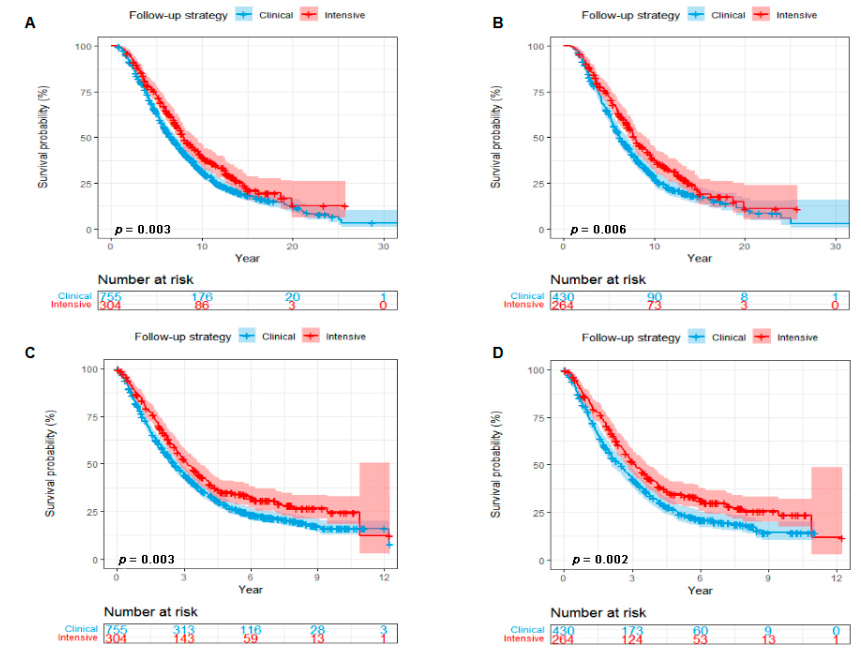
Figure 2. Kaplan–Meier curves showing a comparison of survival among patients with breast cancer with BM according to postoperative follow-up strategy (Intensive postoperative BS vs. Clinical postoperative BS). OS curves before ( A ) and after ( B ) PSM. OSABM curves before ( C ) and after ( D ) PSM. Abbreviations: BS = bone scan; BM = bone metastasis; OS = overall survival; OSABM = overall survival after diagnosis of bone metastasis; PSM = propensity scores matching. Table 2. Univariate and multivariate analysis of clinicopathological factors affecting OS and OSABM among eligible patients (N = 694) after